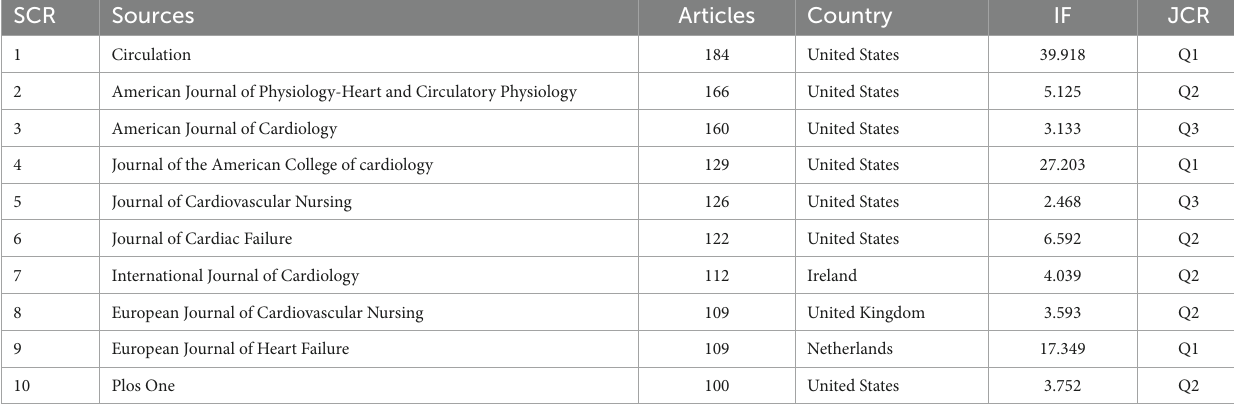
TABLE 2 Top 10 journals with most publications in the field of heart failure and depression. SCR